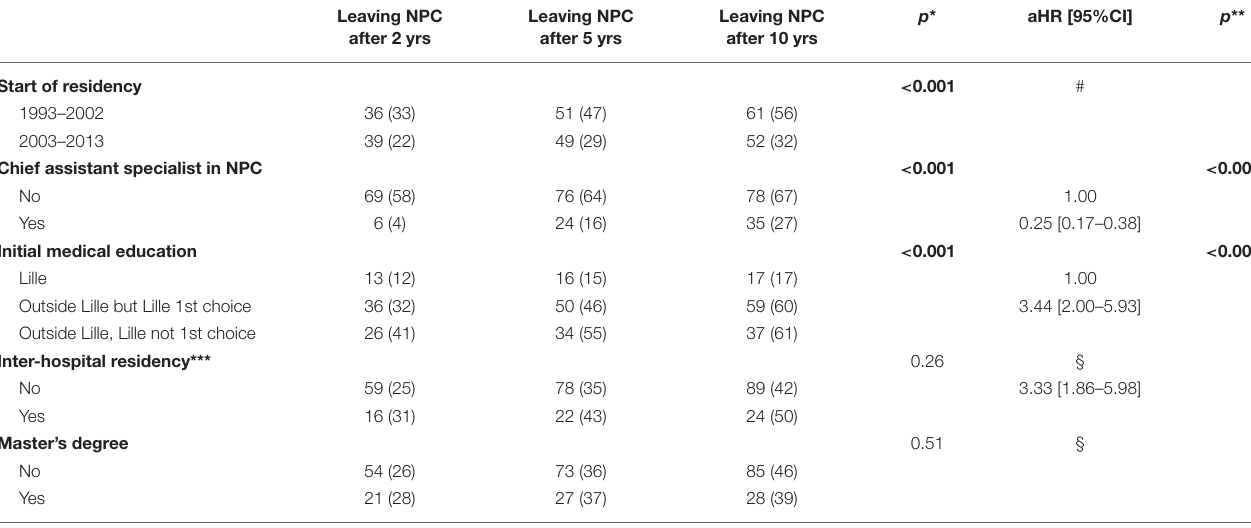
Values are expressed as number (percentage). aHR, adjusted Hazard Ratio; CI, confidence interval; NPC, Nord Pas-de-Calais area.